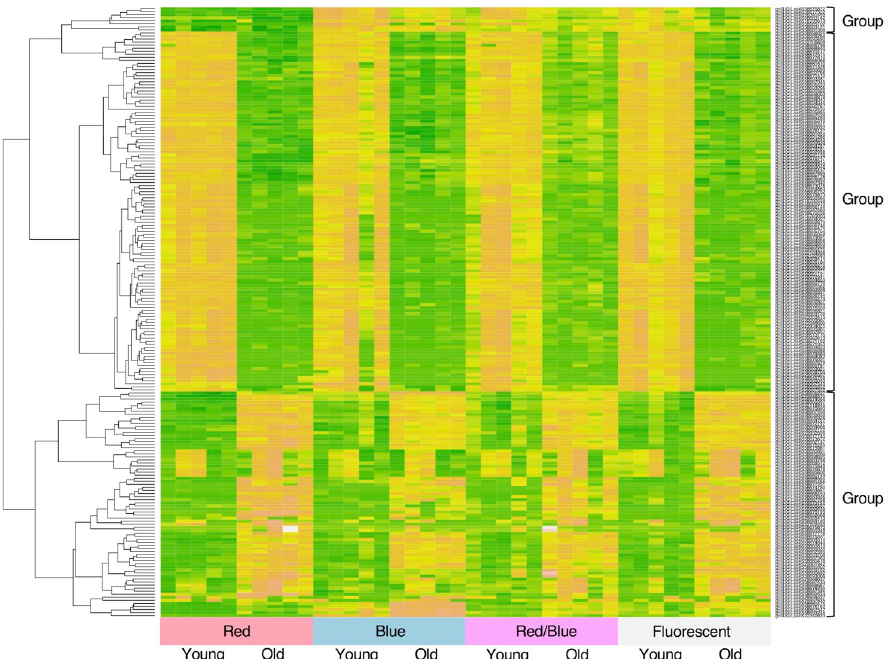
Fig 5. Dendrogram and heat map of the gene expression of the 200 genes with largest variation. The horizontal distance in each branch of the dendrogram represents the degree of similarity between the gene expression profiles of the samples. Each of the columns of the heat map represents an individual. High, intermediate, and low expression levels are shown in pink, yellow, and green colors, respectively. Three groups with the characteristic expression patterns are shown as follows; (i) highly expressed except for the plants grown under the red LEDs, (ii) down-regulated with leaf aging, and (iii) up-regulated with leaf